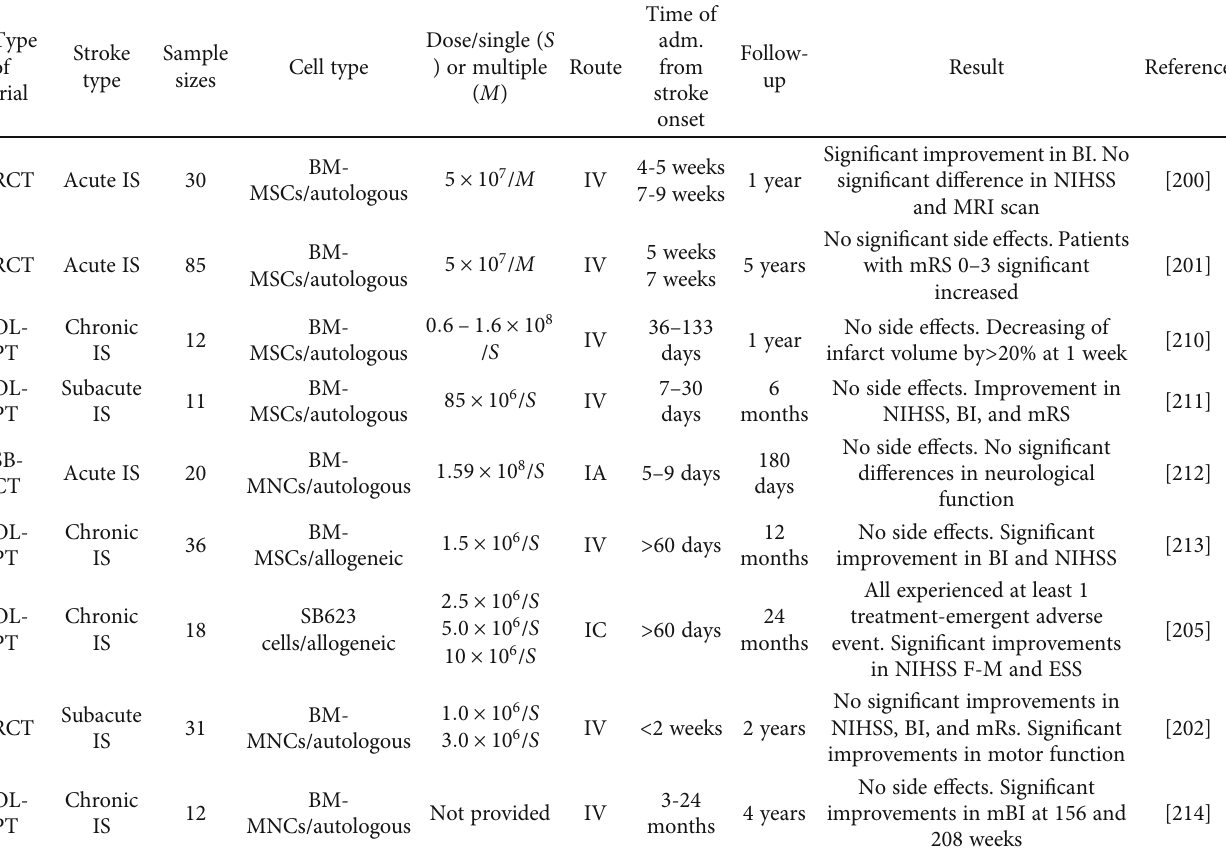
Table 3: Clinical trials of MSCs in the treatment of patients with